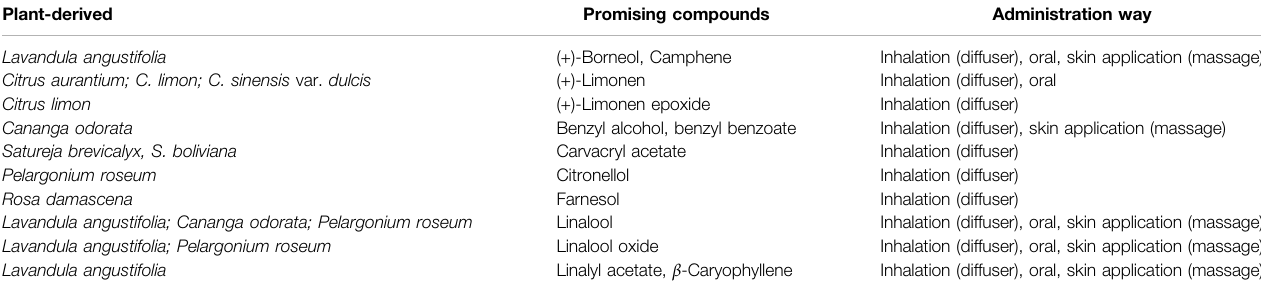
TABLE 5 | Anxiolytic effects of promising compounds from plant-derived essential oils in clinical trials (Zhang and Yao, 2019). Plant-derived